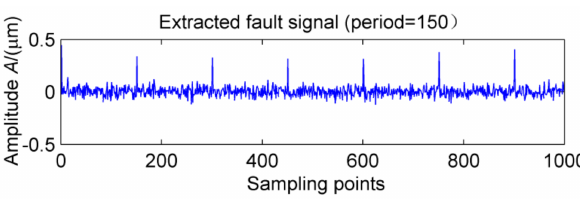
Figure 4. MOMEDA-filtered output impact signal at a period of T = 150.